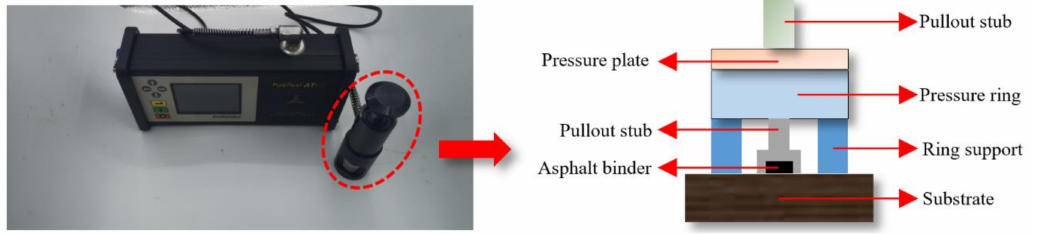
Figure 3. Bitumen bond strength (BBS) test